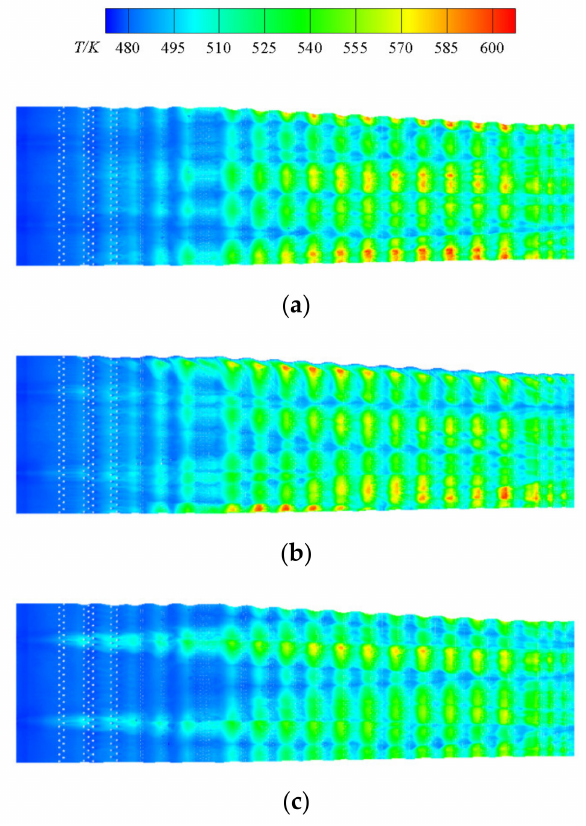
Figure 14. Temperature distribution of heat shield under cases with different cooling flow path structure parameters: ( a ) baseline model; ( b ) r 4 e 1; ( c ) r 1 e